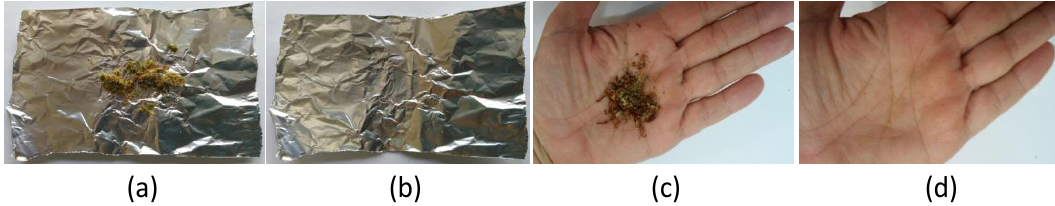
Figure 3. Images obtained in the studies for the analysis of residues of cannabis on: aluminum foil in contact with cannabis ( a ) and after the removal of the plant ( b ); hand of a volunteer in contact with cannabis ( c ); and after the removal of the plant ( d ).